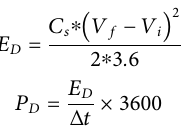
Table 4-(7) in C sp @ three-electrode con fi guration.